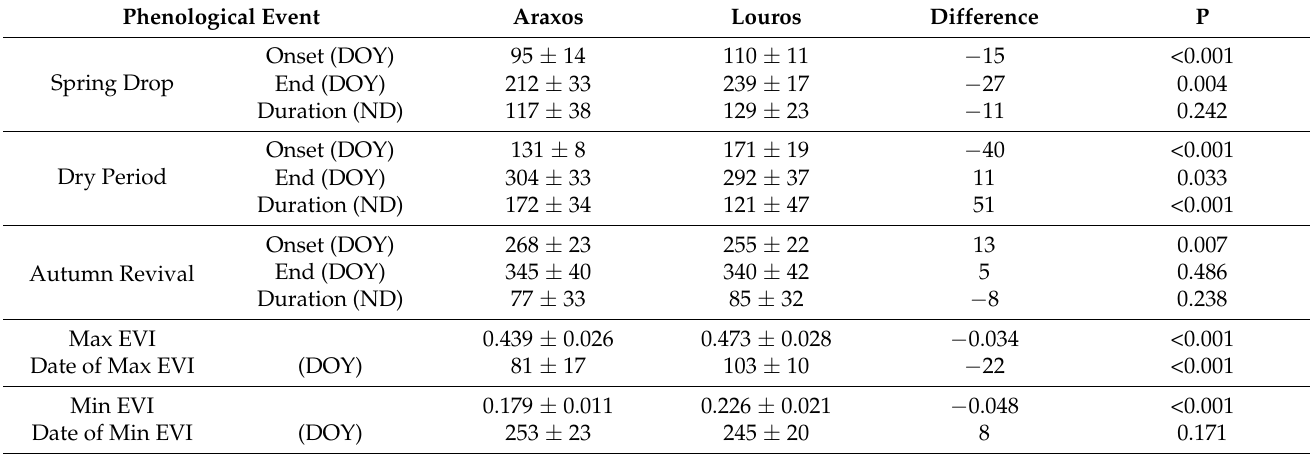
Figure 5. Interannual EVI fluctuation for the 21-year study period for the two study sites ( a ); EVI fluctuation and the corresponding precipitation profile during a dry (2001, b ) and a wet (2016, c ) year in the two study sites. The blue line marks the threshold for dry period onset and end (EVI = 0.3). Table 2. Average data ( ± SD) for the phenological events described in Table 1 for the two study sites, their difference (Araxos–Louros), and the significance of their difference (P, paired t -test). DOY, Day of Year; ND, Number of